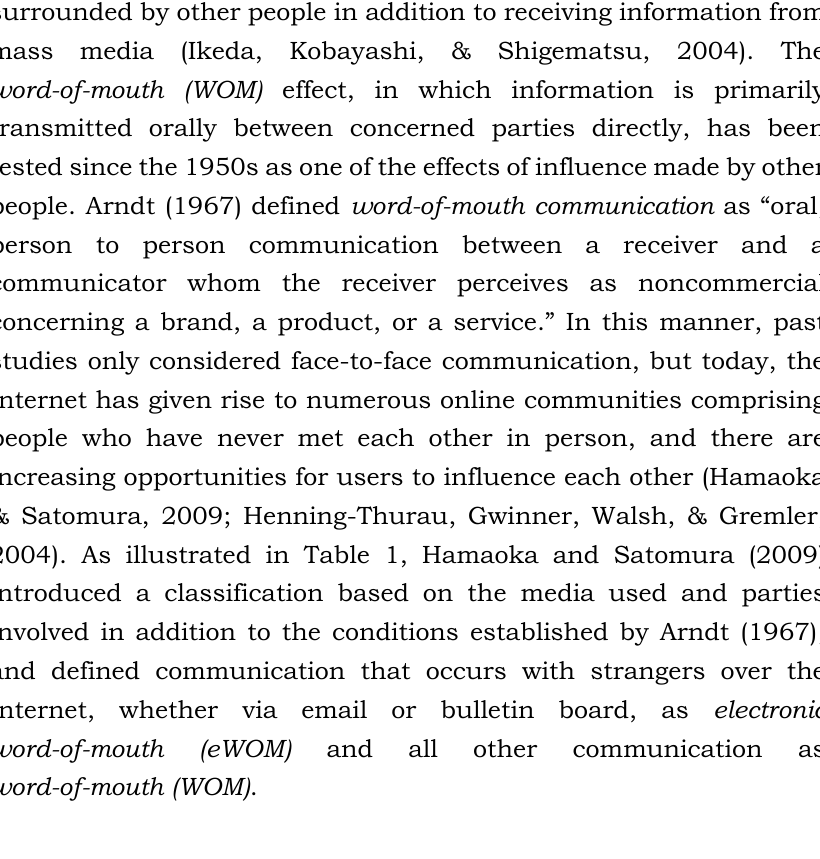
Table 1. Classification of WOM and eWOM